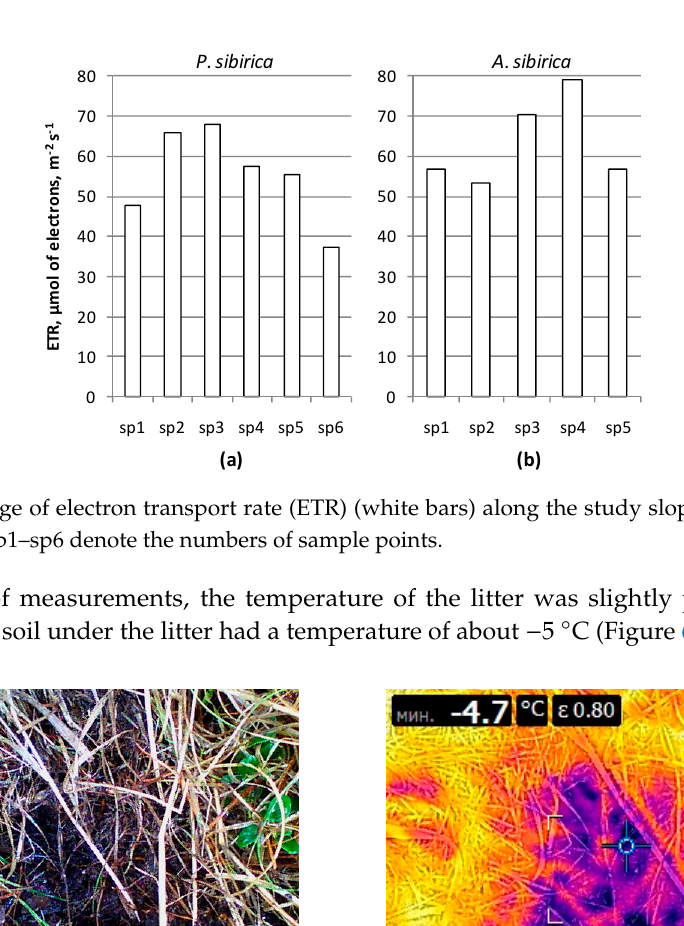
Figure 5. Change of electron transport rate (ETR) (white bars) along the study slope: ( a ) P. sibirica ; ( b ) A. sibirica . sp1–sp6 denote the numbers of sample points.